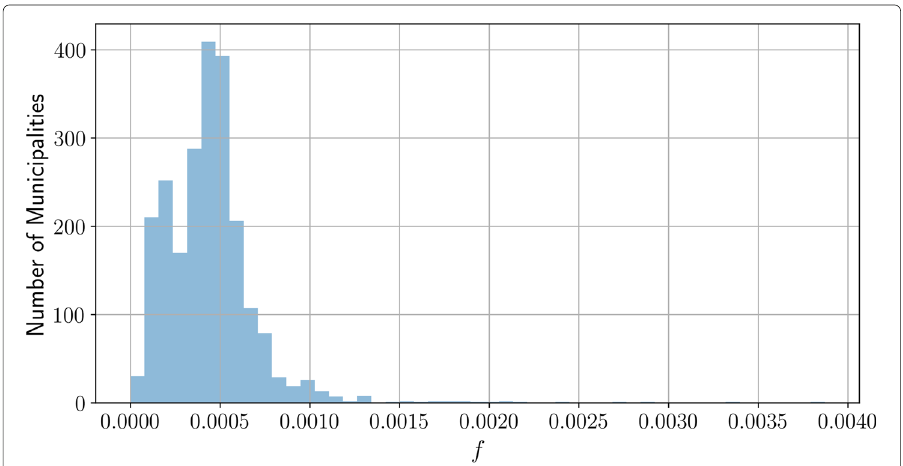
Fig. 1 Number of municipalities in function of